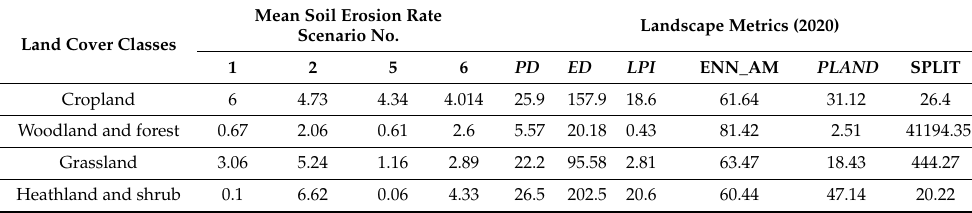
Table 12. Landscape metrics and mean soil erosion rate for 2020 for each land cover class.